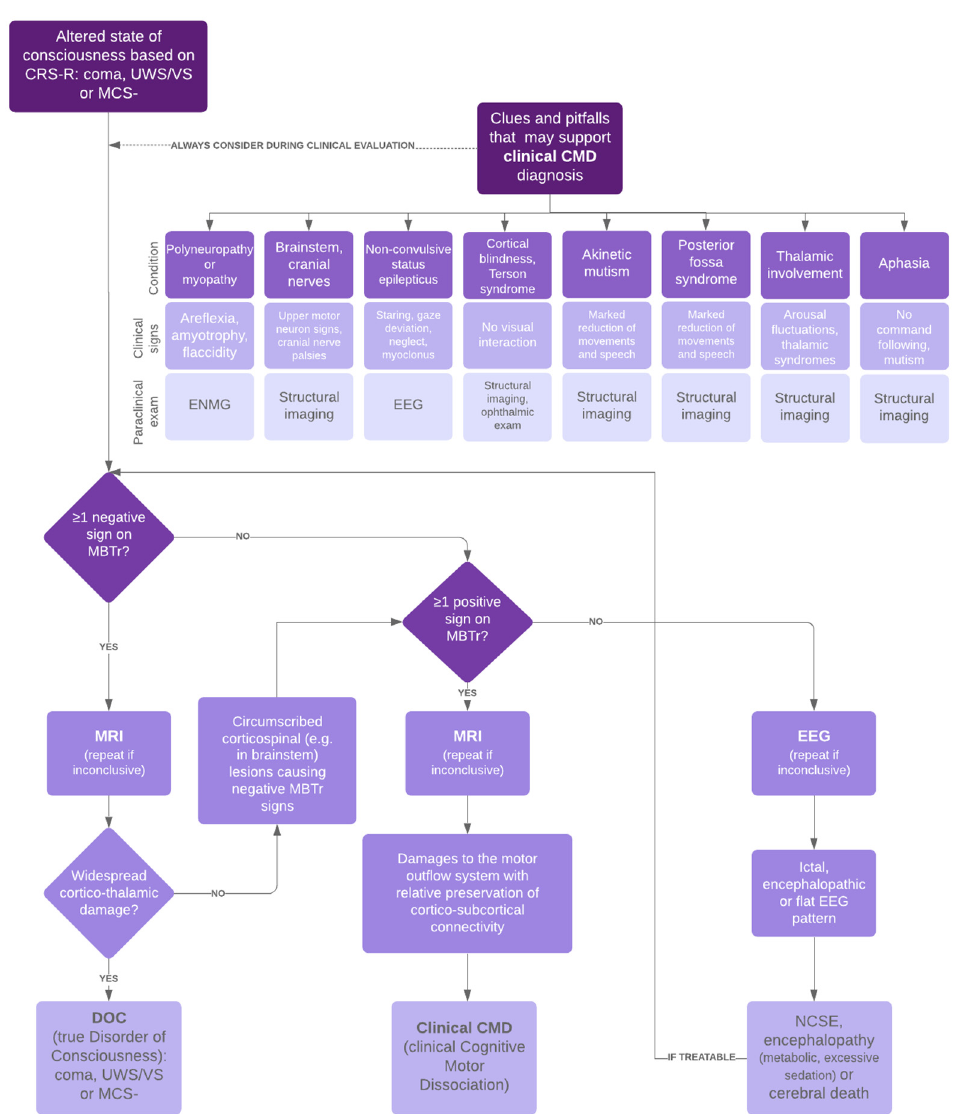
Figure 1. Acute assessment of patients with major cerebral impairment. CRS-R Coma Recovery Scale-Revised, UWS/VS unresponsive wakefulness syndrome/vegetative state, MCS- minimally conscious state minus, clinical CMD clinical cognitive motor dissociation, ENMG electromyoneurography, EEG electroencephalography, MBTr Motor Behaviour Tool-revised, MRI magnetic resonance imaging, DOC disorders of consciousness, NCSE non-convulsive status epilepticus. A neuroradiological evaluation confirmed these suspicions. MRI of the brain re- vealed a discrete extra-cranial cerebral herniation, perivenular haemorrhages of the left frontal cortical-subcortical junction and the corpus callosum suggesting traumatic haem-